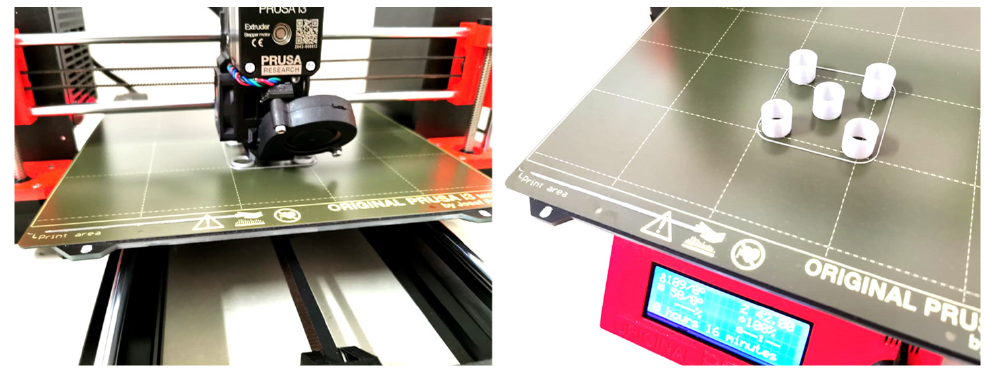
Figure 3. Printing process.